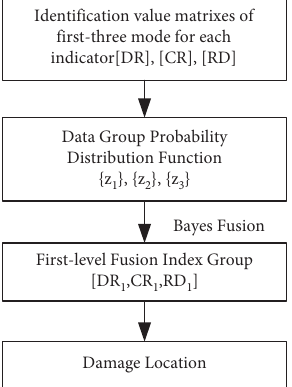
Figure 4: First-level fusion method based on Bayes